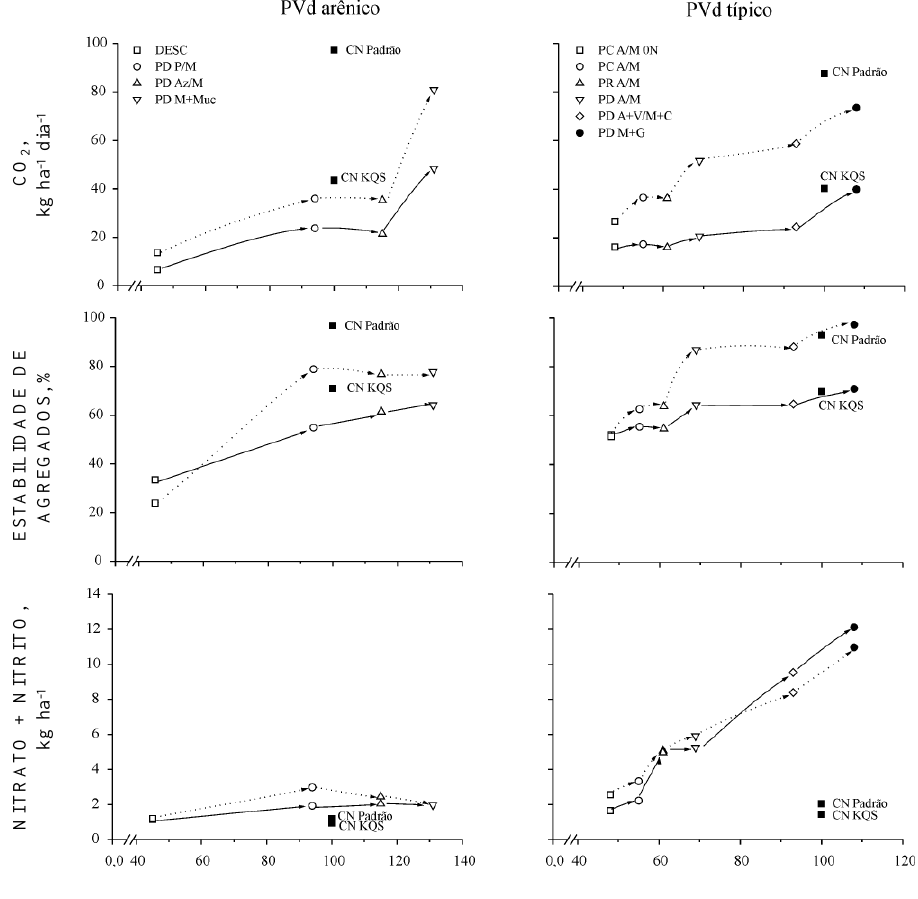
ÍNDICE ESTOQUE DE Figura 2. Relação entre o Índice de Estoque de Carbono (IEC) e os indicadores respiração do solo (CO ), 2 estabilidade de agregados em água e nitrato+nitrito, avaliados pelos métodos padrão (linha pontilhada) e do kit de qualidade do solo (linha cheia). DESC. = solo descoberto; CN = campo natural; PC = preparo convencional; PR = preparo reduzido; PD = plantio direto; Az = azevém; P = pousio; Muc = mucuna; A = aveia; M = milho; V = ervilhaca; C = caupi; G = guandu e 0N = sem adubação nitrogenada. PVd arênico = Argissolo Vermelho distrófico arênico; PVd típico = Argissolo Vermelho distrófico típico.